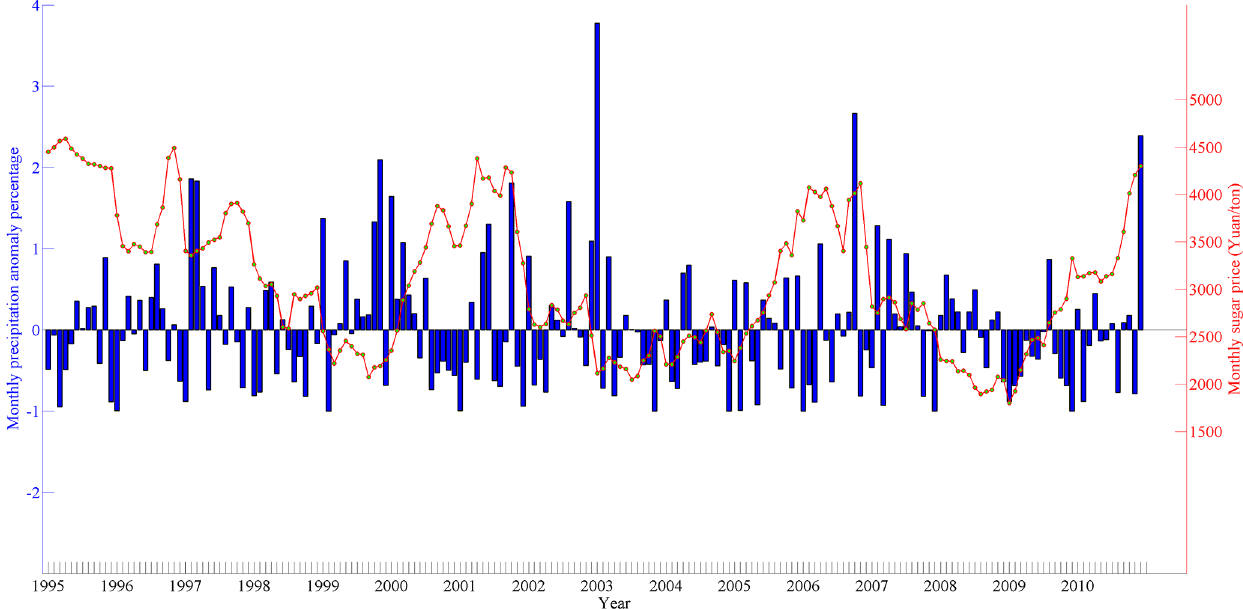
Figure 2. Comparison of precipitation anomalies and sugar price from 1995 to 2010 in